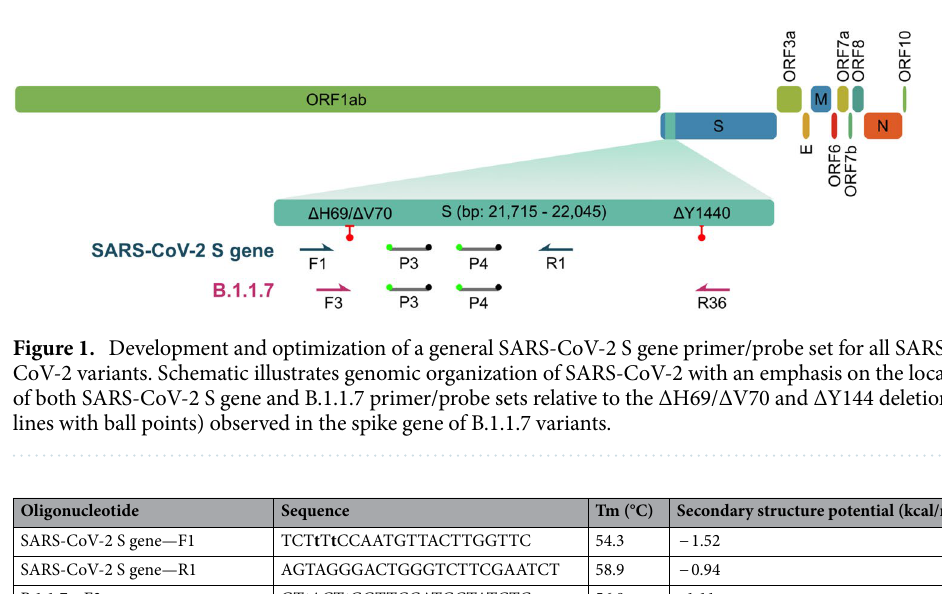
Oligonucleotide